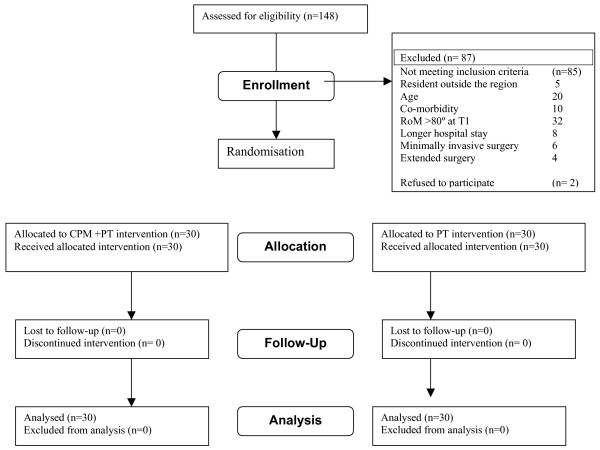
Flowchart of subjects through the trial.